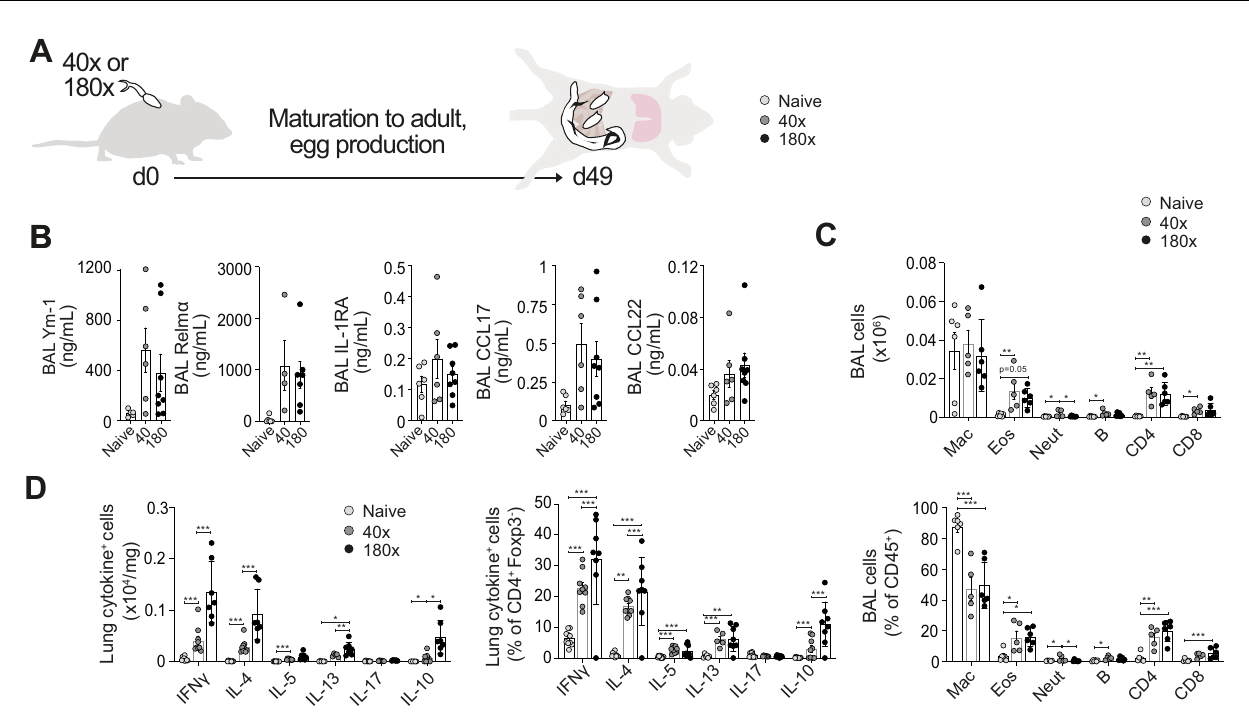
Fig. 3 | Mixed Th2/Th1 pulmonary responses in pre-patent (lung migratory) murine schistosome infection. A C57BL/6 mice were percutaneously infected with 40 or 180 cercariae, and samples taken at d21. B In fl ammatory mediators in BAL were assessed via ELISA. C BAL cell isolates were assessed via fl ow cytometry for macrophages, eosinophils, neutrophils, B cells, CD4 + and CD8 + T cells. D Lung cell isolates were stimulated with PMA/ionomycin, and cytokine production